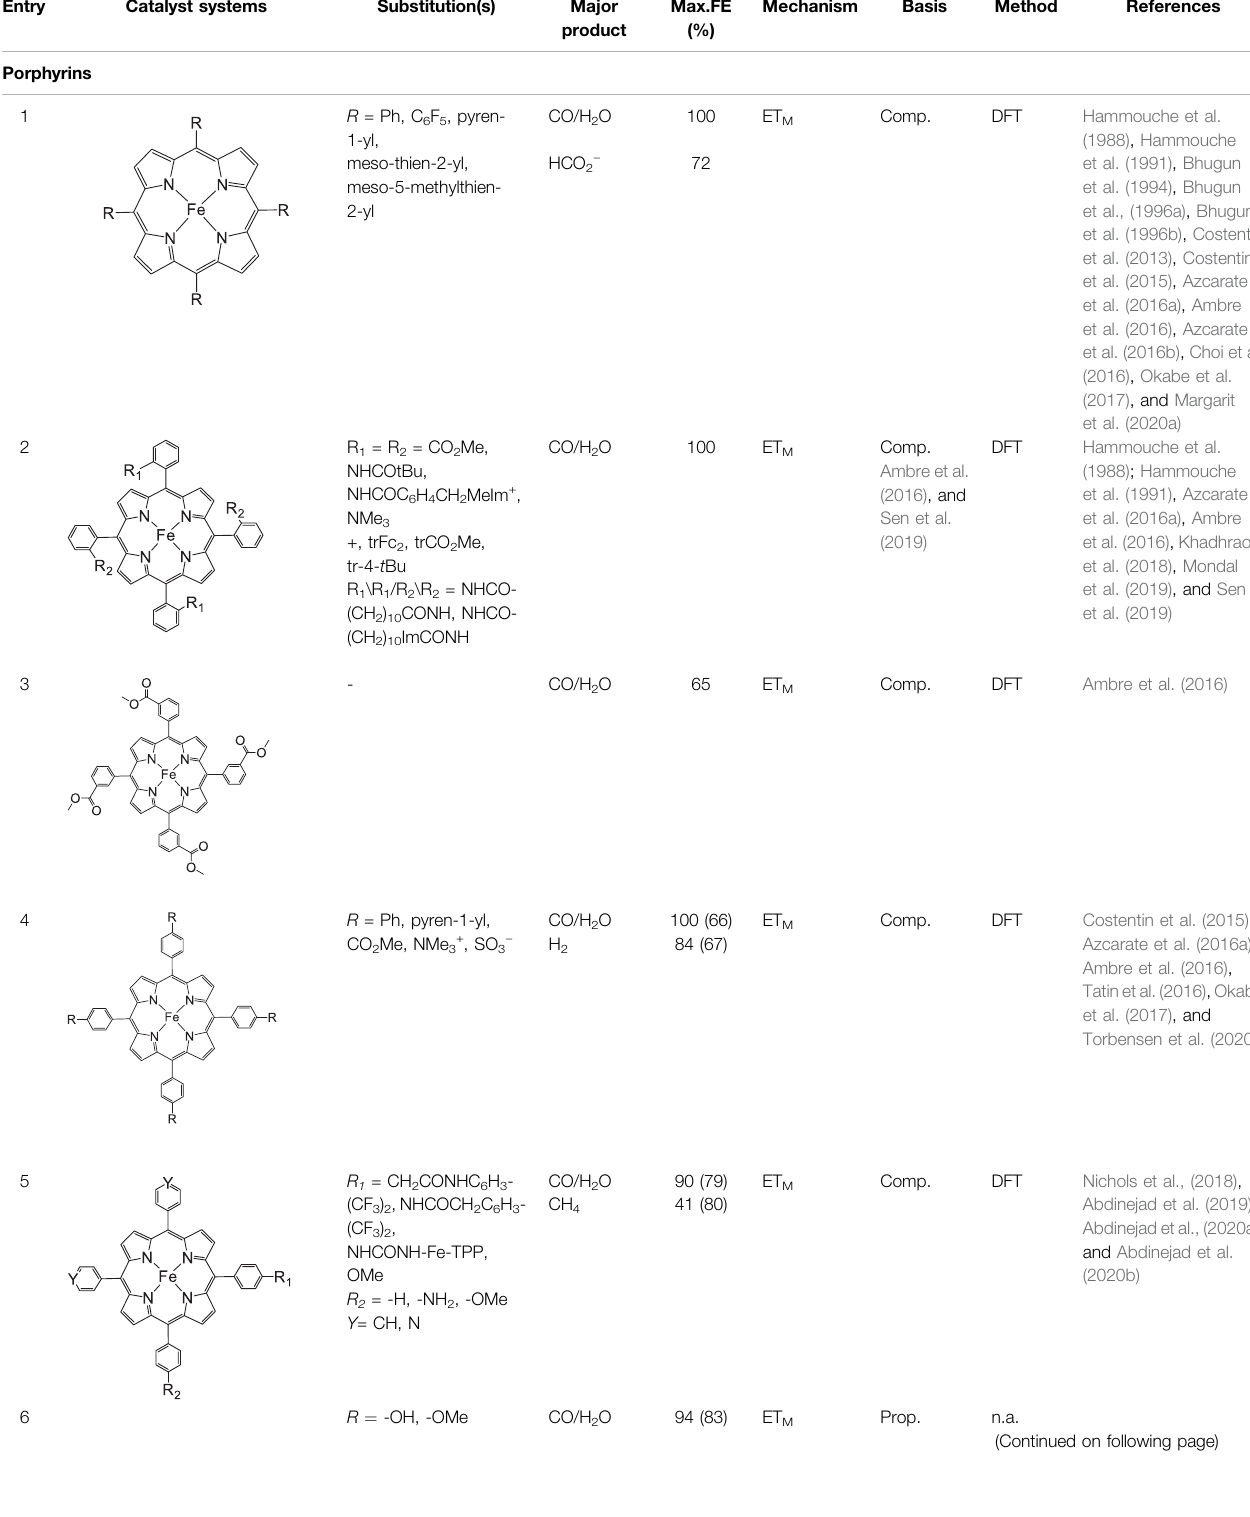
TABLE 2 | Comparison of catalyst systems, major products, maximum FEs, and mechanisms of macrocyclic complexes in electrochemical CO 2 reduction (n.a., not available; prop., proposal; comp., computational investigation; exp., experimental evidence). Entry Catalyst